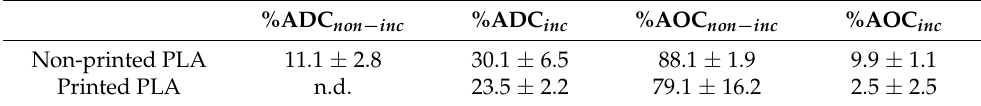
Figure 12. MLE release profile of non-printed and printed samples. Table 5. Bioactivity of the NPIS and PIS before and after a 9-day incubation in